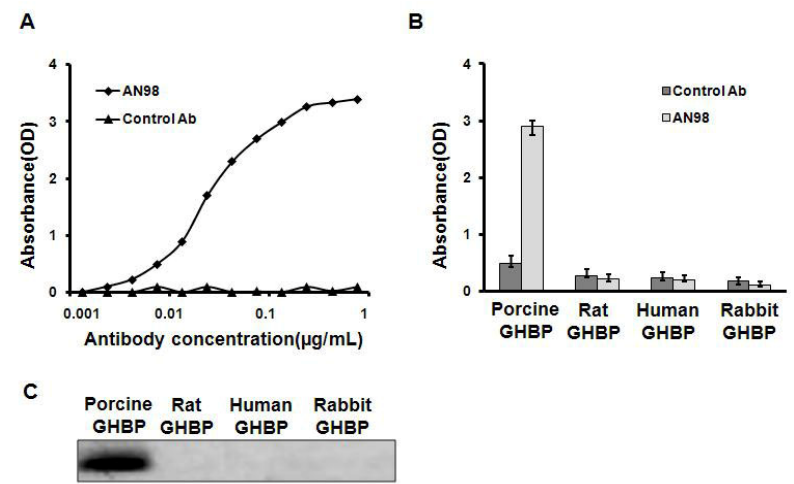
Figure 1. AN98 specifically recognized porcine GHBP. (A) AN98 reacted with porcine GHBP. ELISA plates were coated with porcine GHBP, after blocking and washing, different concentrations of AN98 or the control antibody were added, and followed the treatments described in the materials and methods. (B) AN98 specifically recognized porcine GHBP in ELISA assays. ELISA plates were coated with GHBP from different species. After blocking and washing, the AN98 and the control antibody were added. (C) AN98 specifically recognized porcine GHBP, identified by western blot assays. The GHBPs from different species were separated by SDS-PAGE an d transferred to a PVDF membrane, after blocking the membrane with 5% non-fat milk, the membrane was probed with AN98 and the control antibody. The figures represent at least three independent experiments. GHBP, growth hormone binding protein; ELISA, enzyme- linked immunosorbent assay; SDS-PAGE, sodium dodecyl sulfate-polyacrylamide gel electrophoresis; PVDF, polyvinylidene